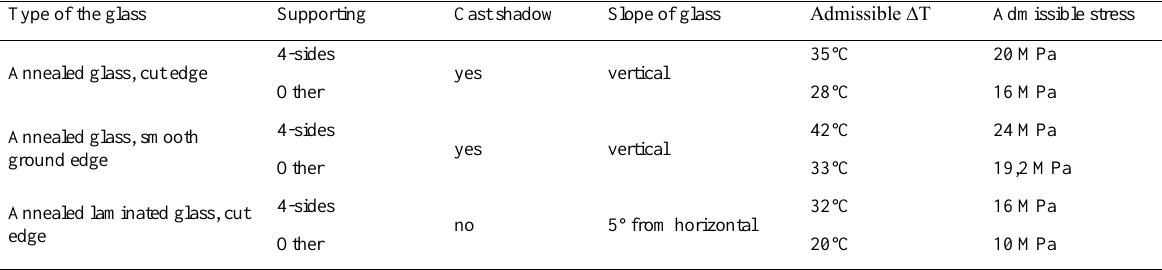
Table 2: Example of influence of shadow, supporting, frame and slope on respectively admissible stress